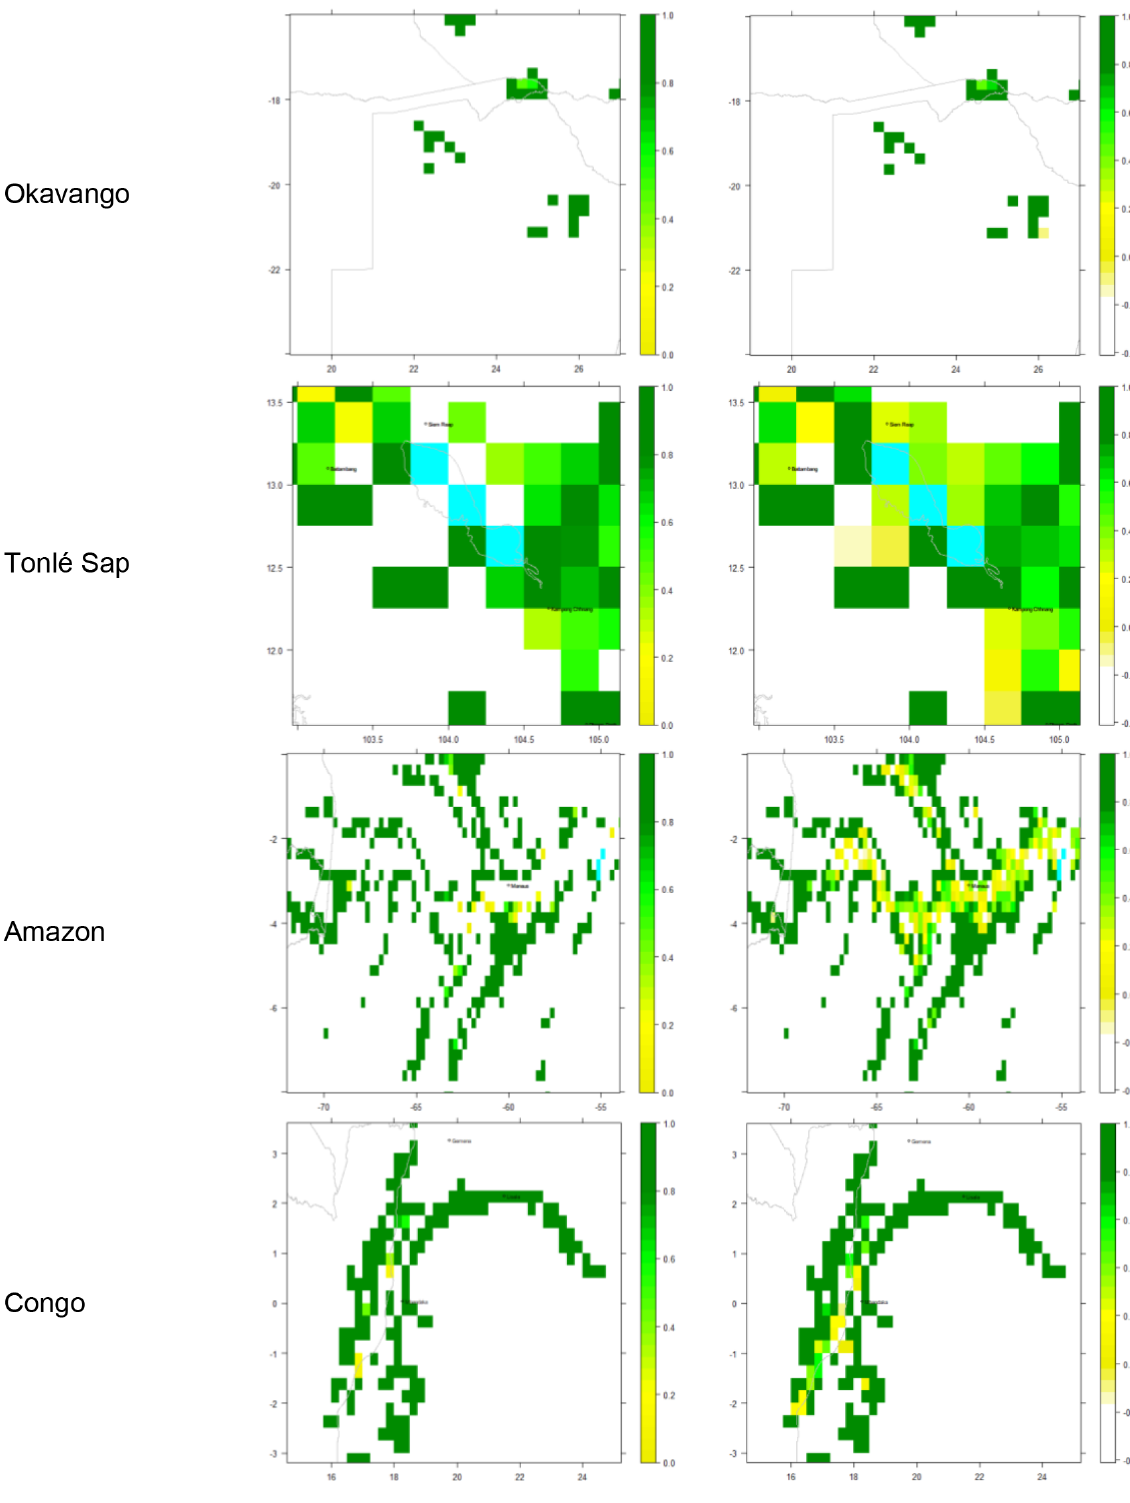
Hydrol. Earth Syst. Sci., 26, 3151–3175, 2022